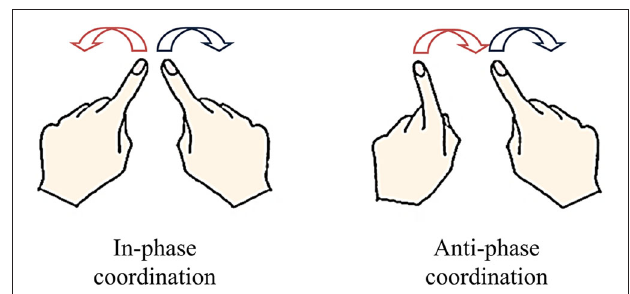
FIGURE 1 | Stable patterns of spontaneous bimanual coordination . The in-phase pattern consists in symmetric movements in opposite directions (0 ◦ of relative phase) involving the simultaneous activation of homologous muscles. The anti-phase pattern consists in parallel movements in the same directions (180 ◦ of relative phase) involving the simultaneous activation of antagonist muscles.